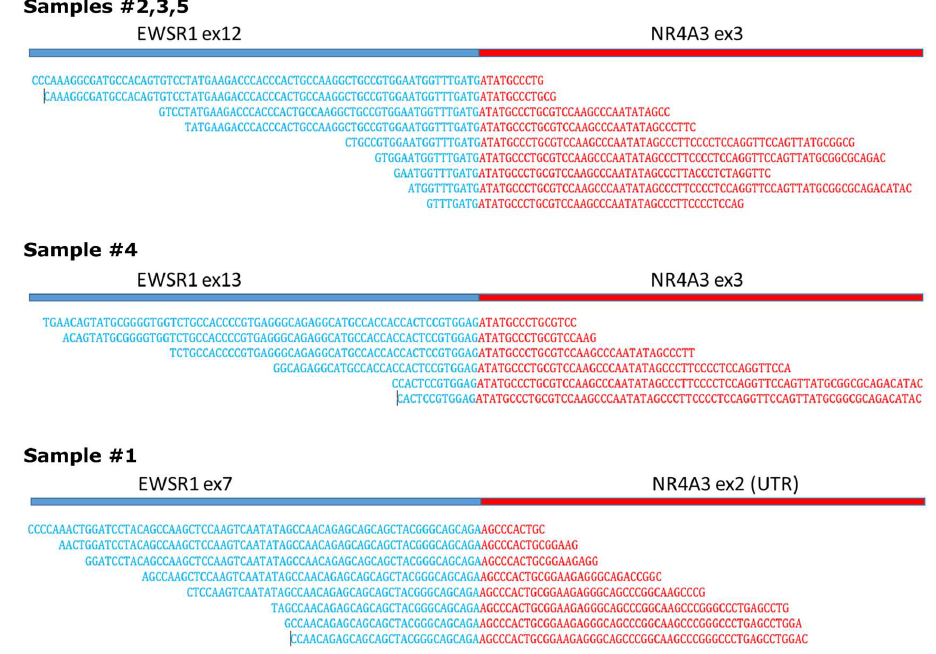
Figure 1. Three different EWSR1-NR4A3 breakpoints identified through whole transcriptome sequencing (WTS).